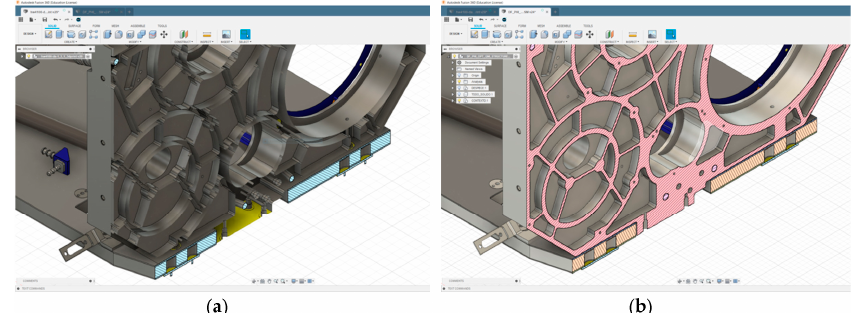
Figure 2. ( a ) Digital model with surface geometries. ( b ) Digital model with solid geometries.